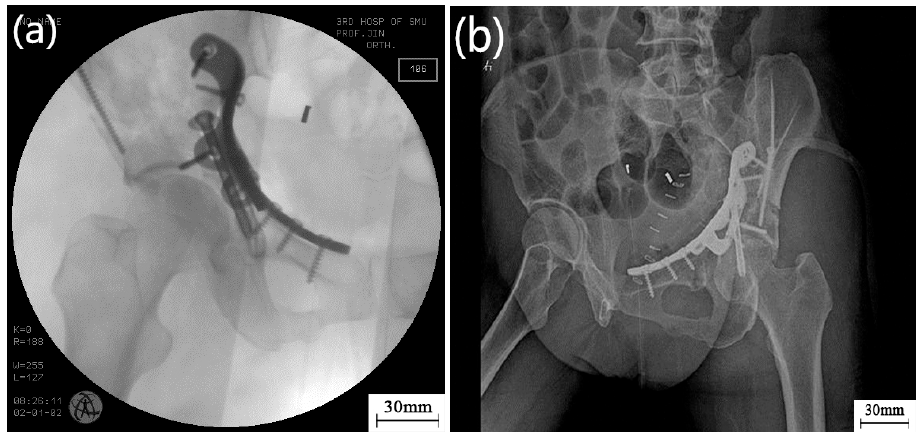
Figure 9. Examination of fixation effect of the bone plate during and after the operation: ( a ) C-arm image during operation; and ( b ) X-ray image following